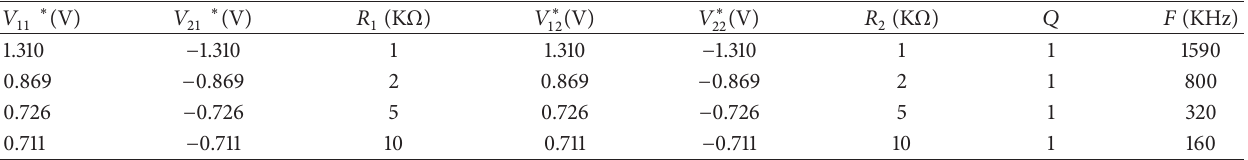
Table 2: Bias voltages/resistor values for orthogonal adjustment of 𝑓 0 and 𝑄 0 .